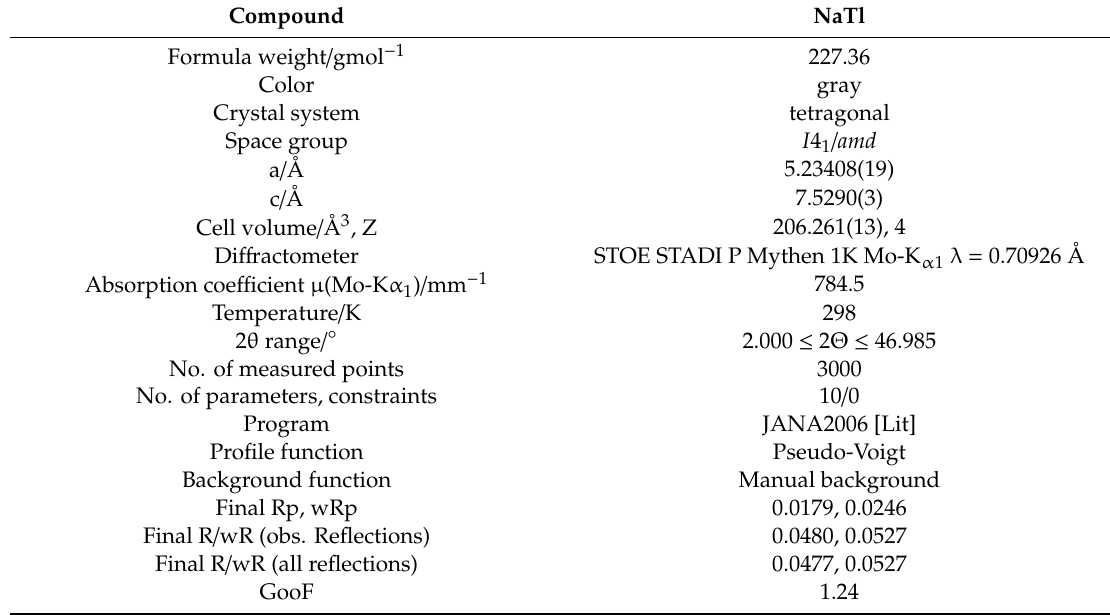
Table 3; anisotropic displacement parameters (ADP’s) are given in Table 4. The comparably large ADP of sodium we assume is due to its thermal motion, as the free refinement of this site resulted in a value of 0.89(6) and no significantly smaller ADP’s. Therefore, the value was fixed at 1.0 (according to site symmetry of